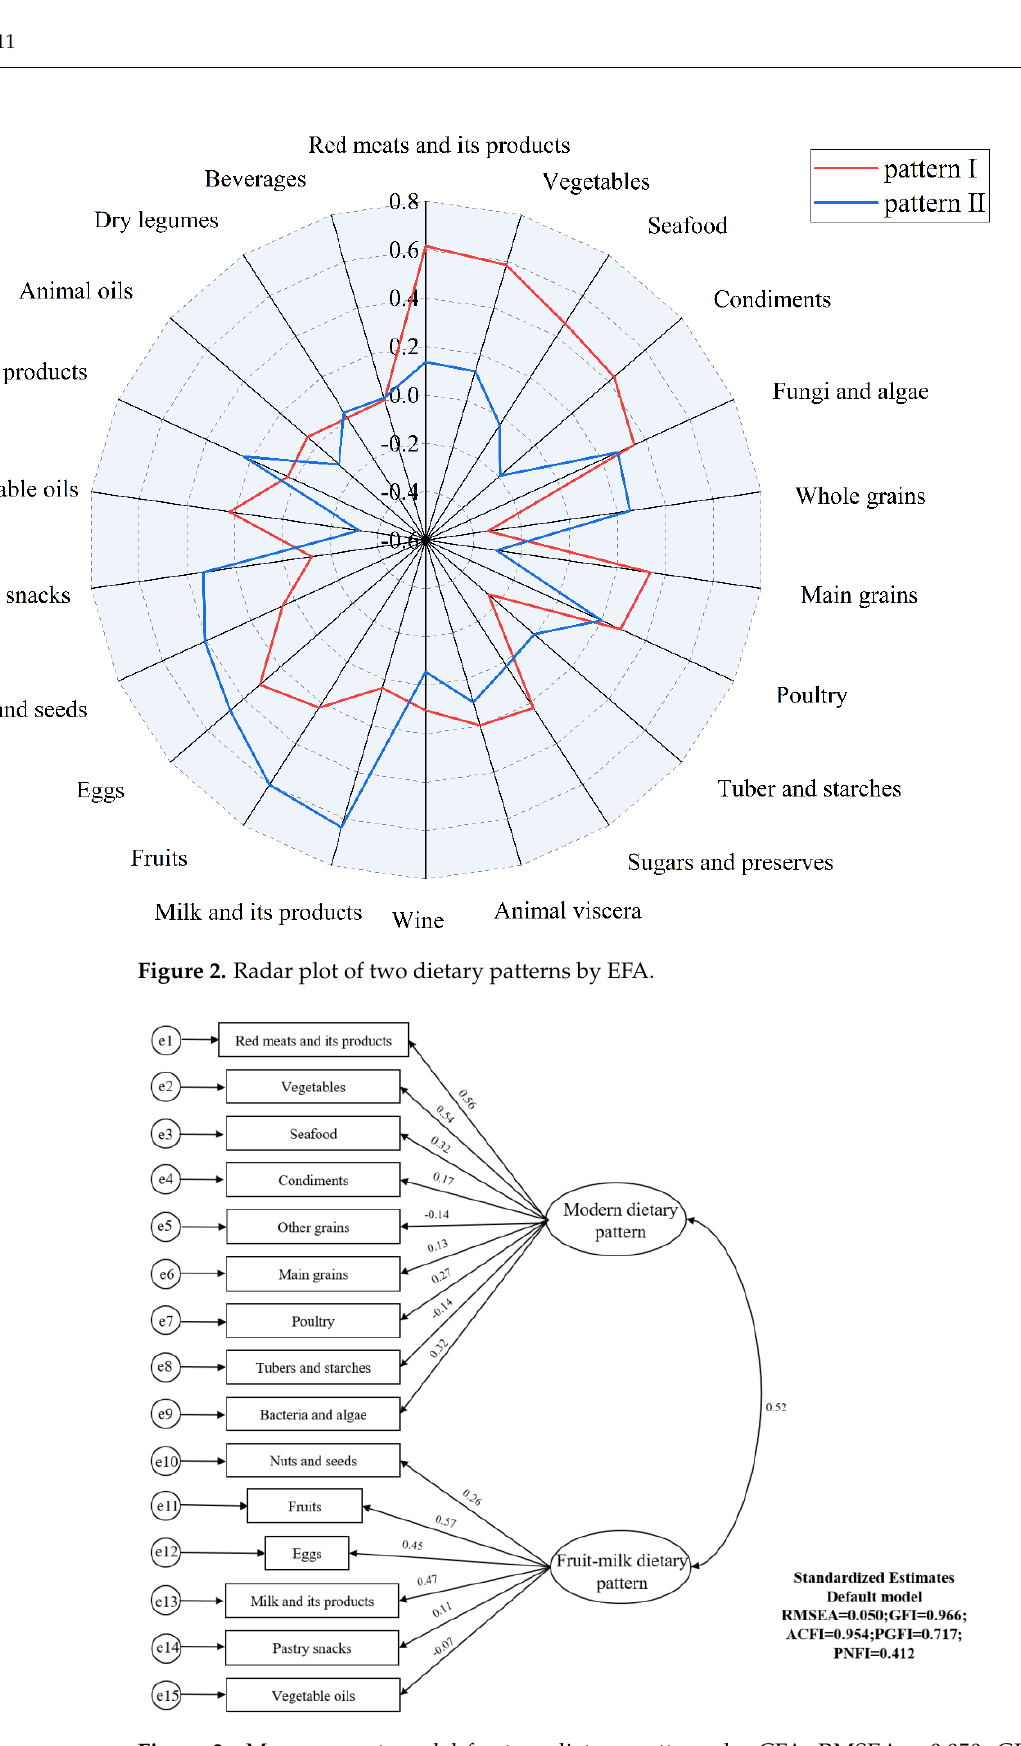
Figure 3. Measurement model for two dietary patterns by CFA. RMSEA = 0.050, GFI = 0.966, ACFI = 0.954, PGFI = 0.717 and PNFI = 0.412. e,